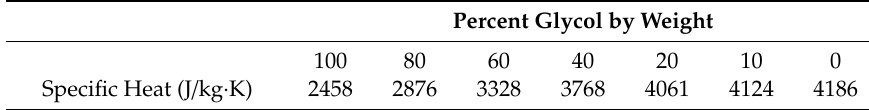
Table 3. Specific heat of propylene glycol-water mixture